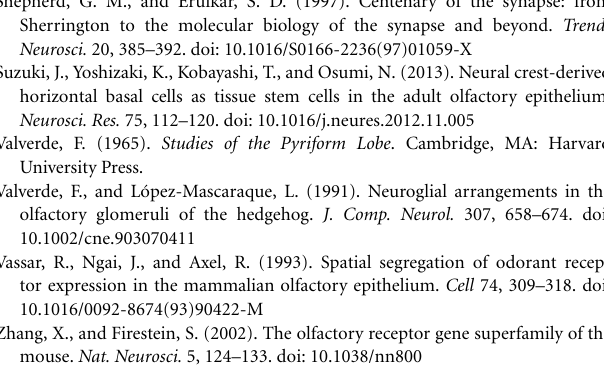
Citation: Figueres-Oñate M, Gutiérrez Y and López-Mascaraque L (2014) Unraveling Cajal’s view of the olfactory system. Front. Neuroanat. 8 :55. doi: